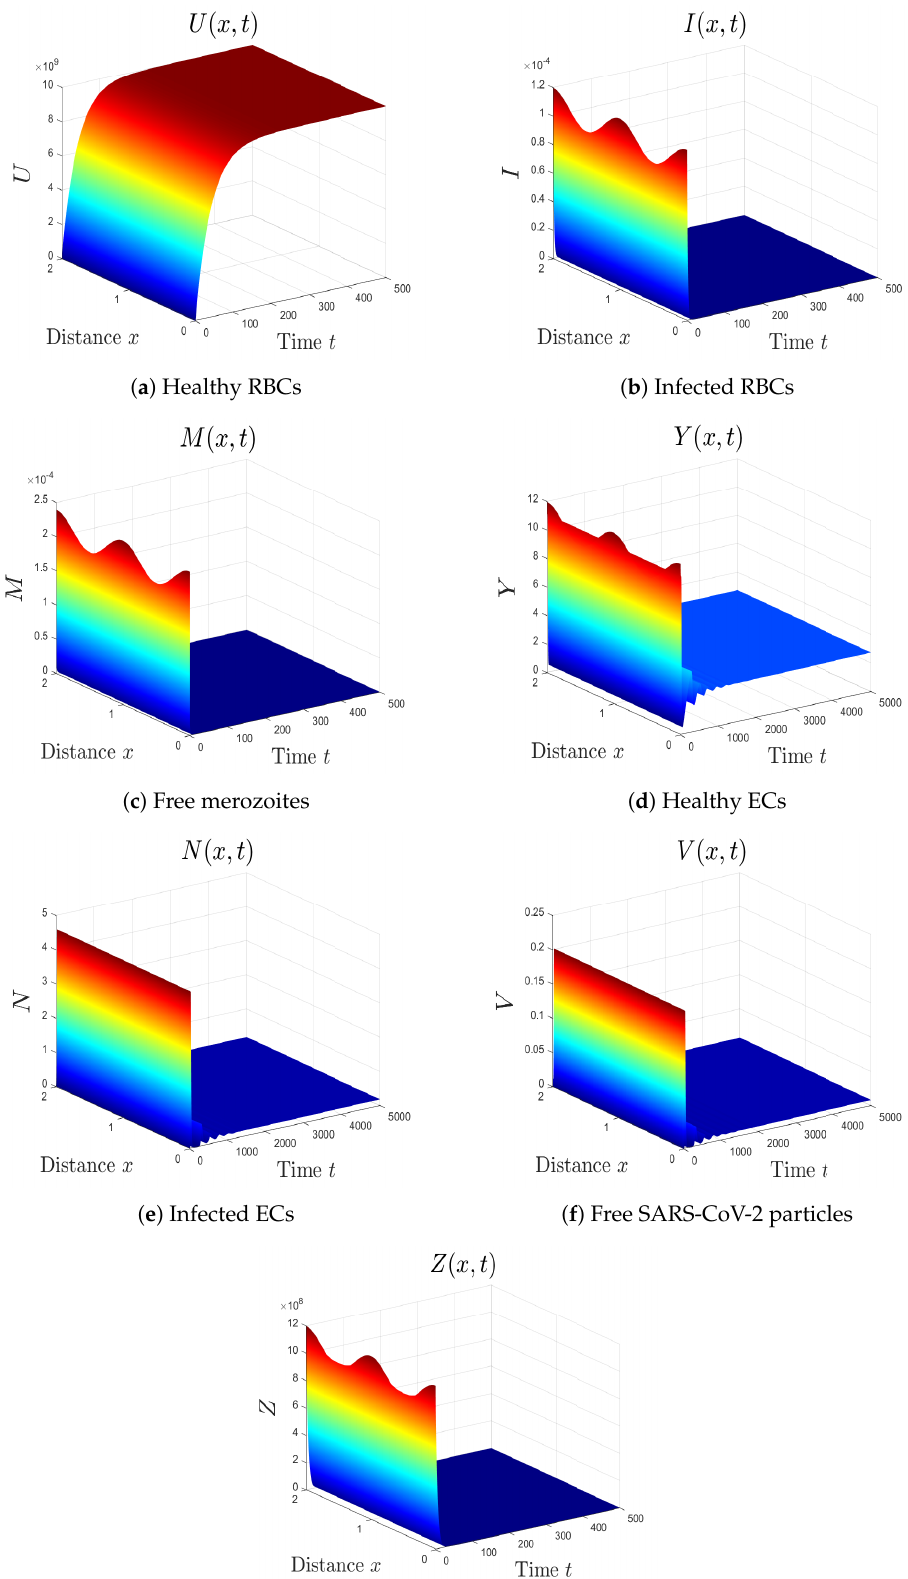
Figure 4. Simulation of system (1) for ( β m , β v , p 1 , p 2 , d 7 ) = ( 2 × 10 − 10 ,0.9,3 × 10 − 8 ,0.96,0.2 ) . The equilibrium E 3 = ( 10 × 10 9 ,0,0,2.73,0.1789,0.008,0 ) is